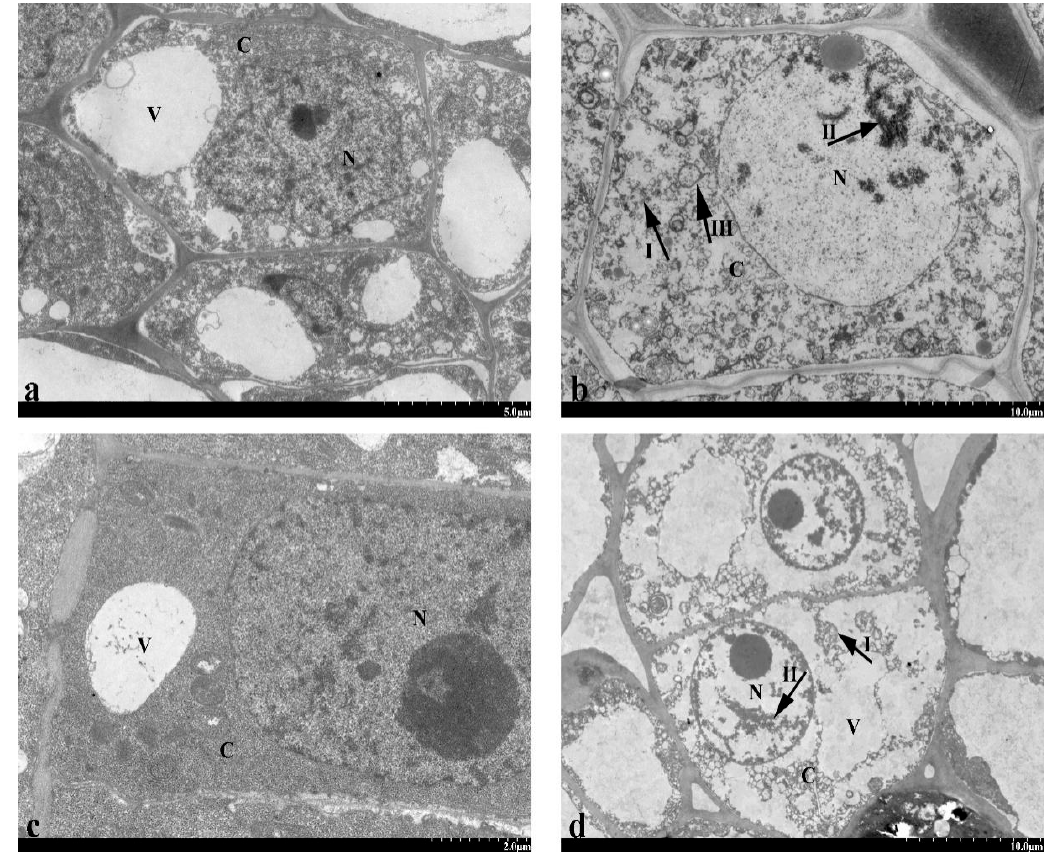
Figure 9. Cells of carpel and stamen in both male and female floral buds collected on April 14, 2017 at the ultrastructural level. ( a ) Normal developmental cells of the stamen in male flowers. ( b ) The cells in the arrested carpel from male flowers showed condensation of cytoplasm (showed by arrow Ⅰ ), fragmentation of nucleoli (showed by arrow Ⅱ ), and engulfment of the cytoplasm by vacuoles (showed by arrow Ⅲ ). ( c ) Normal developmental cells of the carpel in female flowers. ( d ) The cellular contents in the cells of the arrested stamen with shrinkaged cytoplasm and chromatin (showed by arrow Ⅰ and Ⅱ , respectively) in female flowers were degenerated (N = nucleus; V = vacuole; C = cytoplasm).